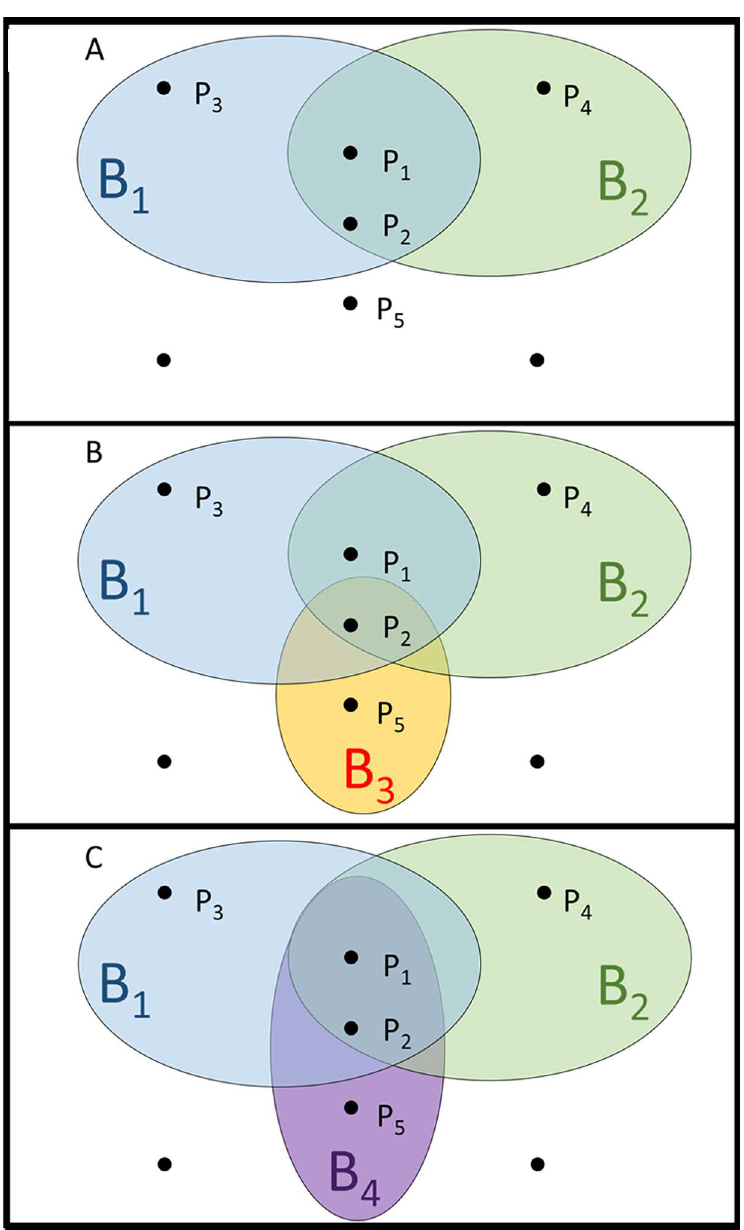
Fig 1. Graphical representation of the proteins (denoted P 1 , P 2 , P 3 , P 4 , P 5 ) which can serve as markers for the bacterial (denoted B 1 , B 2 , B 3 , B 4 ) group of interest consisting of B 1 and B 2 : (A) shows that P 1 , P 2 can serve as a minimal set of markers for the group of interest; (B) P 1 only can serve as a marker for the group of interest; and (C) there are no markers for the group of